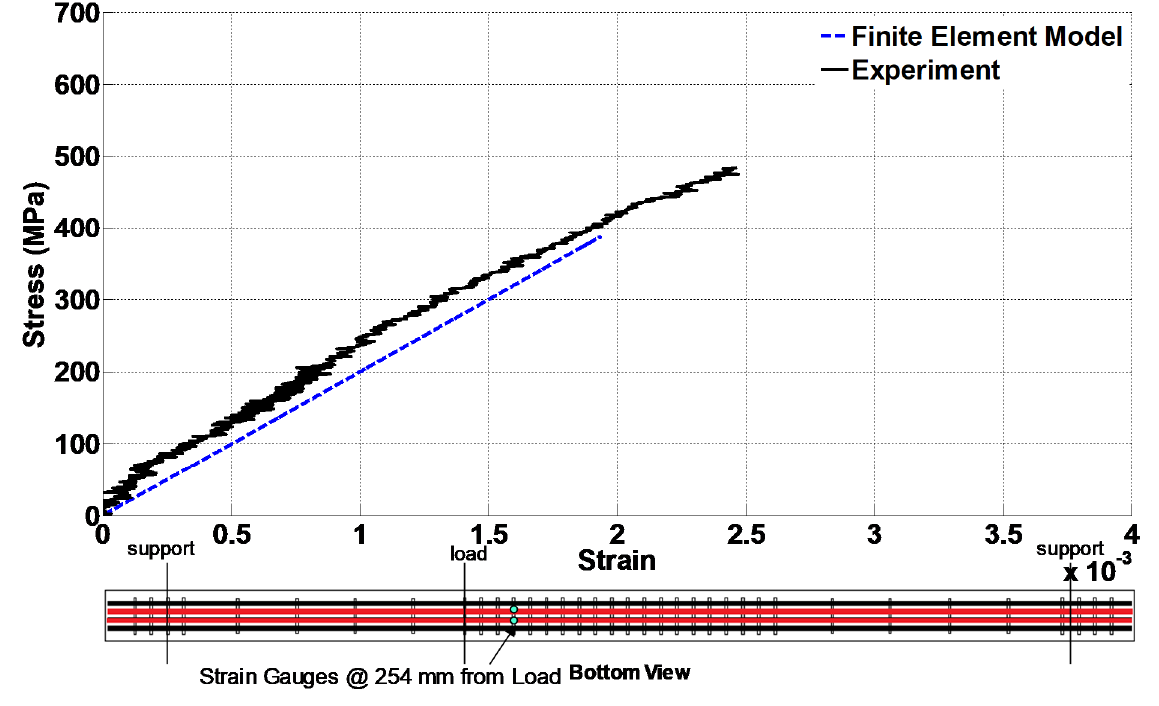
Figure 14. Comparison of the experimental and numerical stress–strain diagrams of the bottom longitudinal rebar close to the loading point.